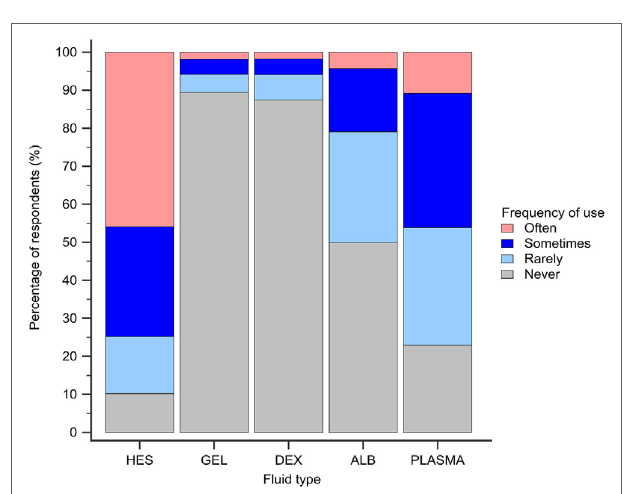
FigUre 5 | Frequency chart showing the relative frequency with which the 1,134 survey respondents use intravenous solutions for colloid osmotic support. HES, hydroxyethyl starch; GEL, gelatin; DEX, dextran; ALB, albumin.